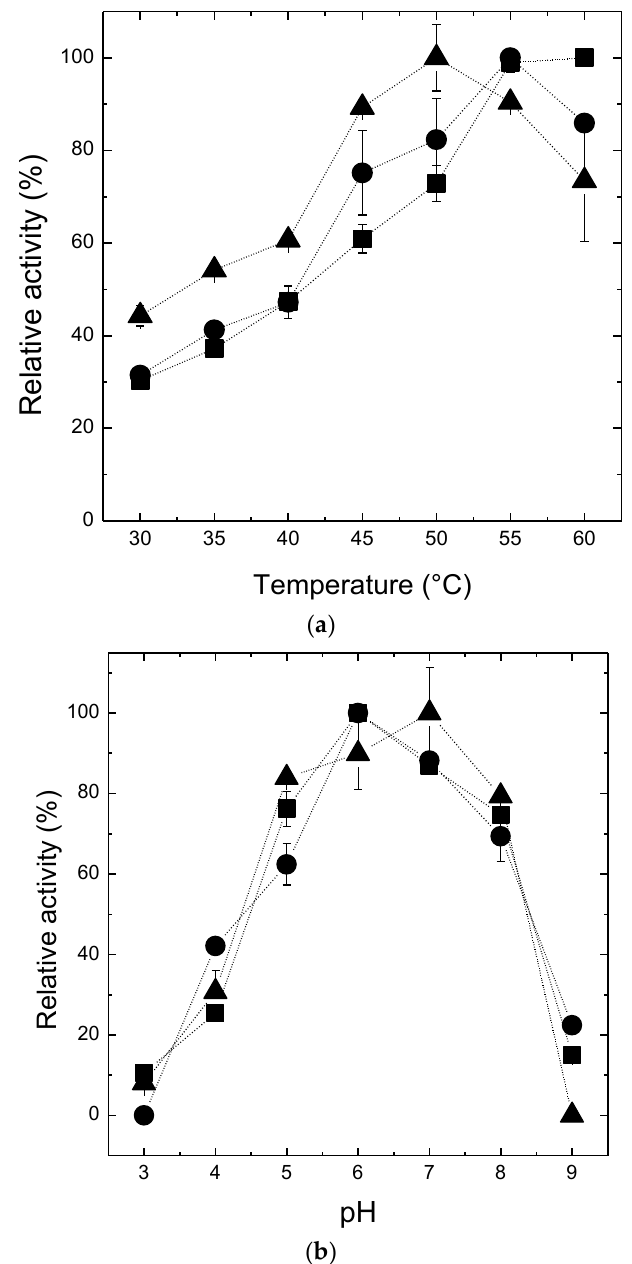
Figure 2. Temperature activity profile ( a ), using 1% ( w / v ) soluble starch solution at pH 4.8 (standard condition for enzymatic assay as described in the section 3.2) and pH activity profile ( b ), using 1% ( w / v ) soluble starch solution at 20 °C, for free β-amylase (squares), CLEA-β-BSA-5 (circles) and CLEA-β-SPI-12 (triangles). The maximum activities were taken as 100%.